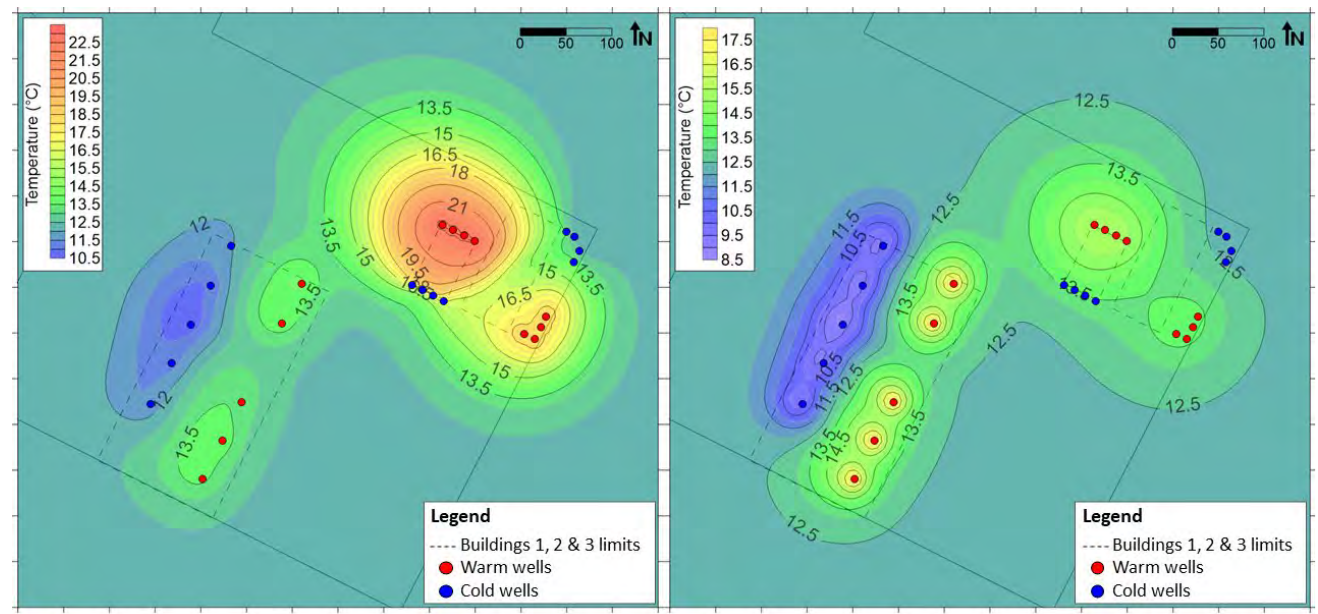
Figure 10. Simulated heat and cold plumes for 1 October 2039 in the shallow ( left ) and in the deep ( right ) aquifer.